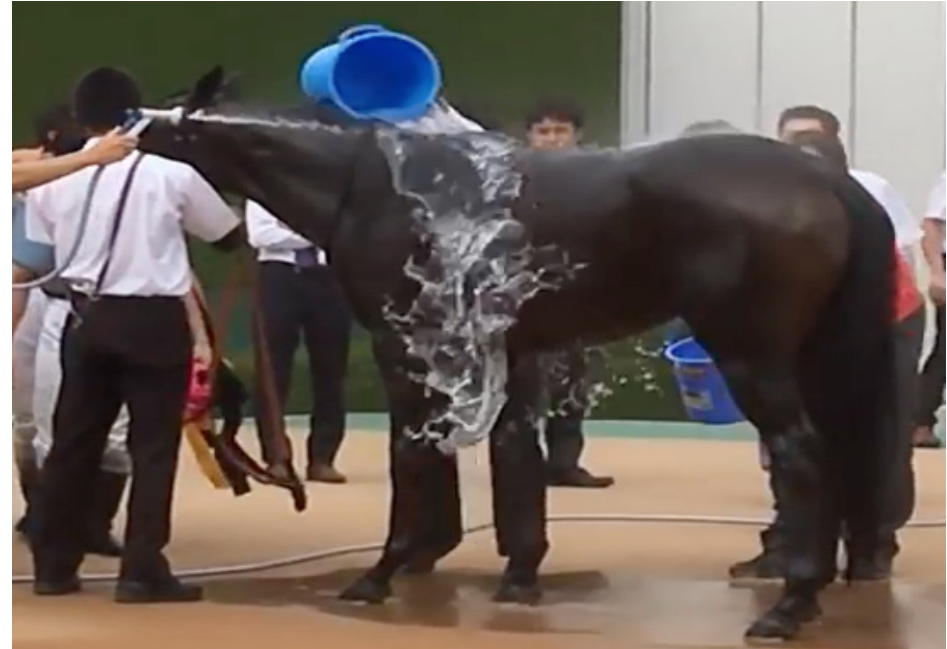
Figure 20. Bucketing water over horses should only ever be a last resort. As can be seen in this photograph, most of the water does not contact the skin surface for any length of time.